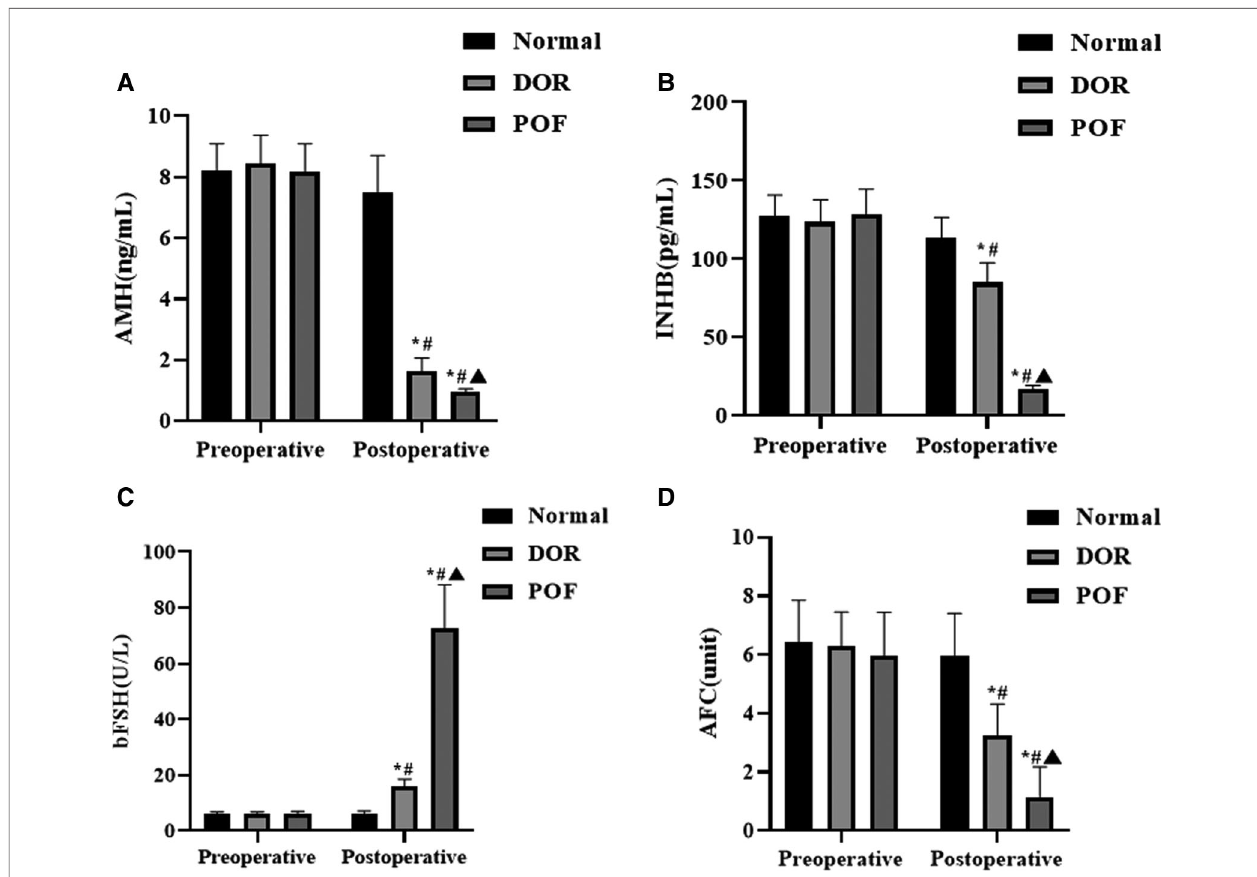
FIGURE 1 | Comparison of postoperative serum AMH, INHB, bFSH and AFC in patients ( n , (cid:1) x + s). Note: ( A ) is AMH, ( B ) is INHB, ( C ) is bFSH, and ( D ) is AFC. Compared with the same group preoperatively * p <0.05; compared with normal group after operation, # p <0.05; compared with DOR group after operation, ▴ p